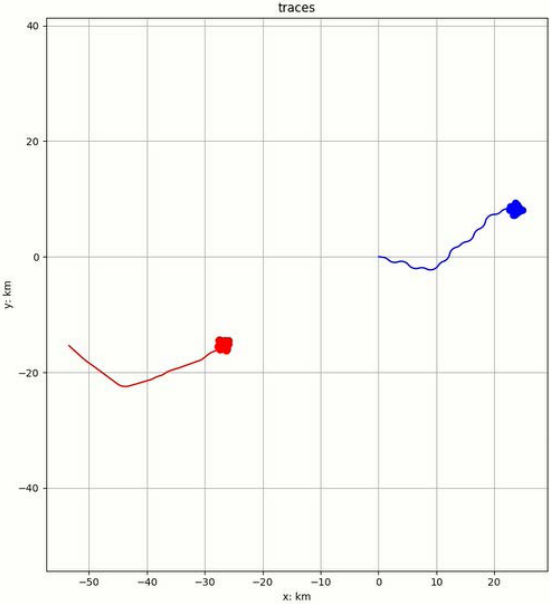
Figure 11. 2D balance: air combat process.